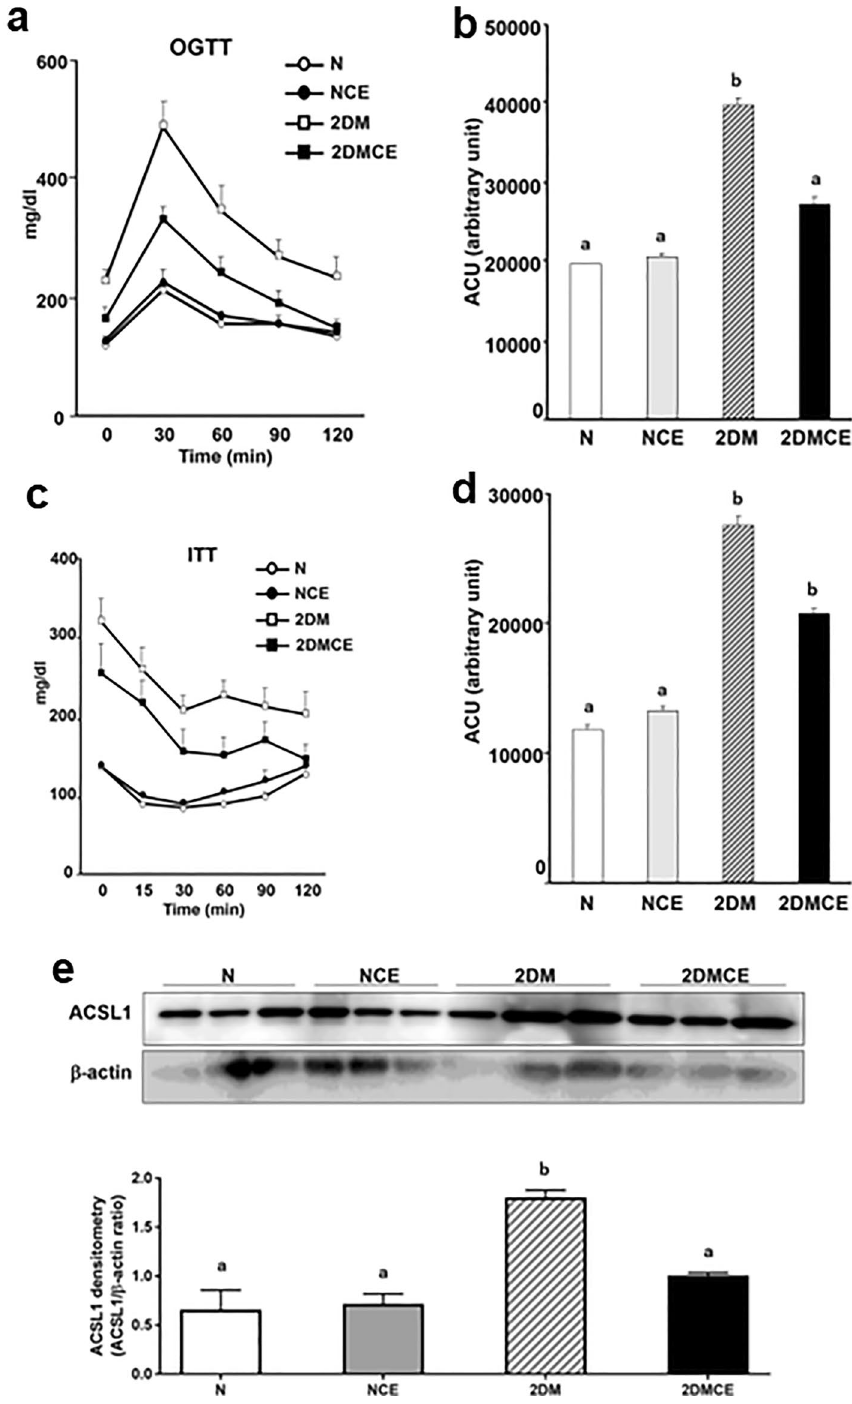
Figure 5. Cinnamon extract (CE) improves glucose intolerance and ACSL1 protein expression in type 2 diabetic mice. N: nondiabetic normal control group. Mice were orally administered 1-mL pure water for 8 weeks. NCE: CE-treated nondiabetic normal control group. CE (100 mg/kg bw/day) was orally administered for 8 weeks. 2DM: type 2 diabetes model mice group. Mice were orally administered 1-mL pure water for 8 weeks. 2DMCE: CE-treated type 2 diabetes model mice group. CE (100 mg/kg bw/day) was orally administered for 8 weeks. ( a ) For the oral glucose tolerance test, the mice fasted for 6 h prior to the test. Glucose (1.5 g/kg bw) was orally administered, and the blood glucose concentration was measured using the blood obtained via the tail vein at the indicated time points after the oral glucose loading. ( b ) The area under the curve (AUC) of the oral glucose tolerance test for panel ( a ). ( c ) For the insulin tolerance test, the rats fasted for 2 h. Then, insulin (0.75 U/kg bw) was intraperitoneally injected, and the blood glucose concentration was measured as previously described. ( d ) The AUC of the insulin tolerance test for panel c. Each value represents the mean ± SD of three different mice (n = 3/group). Alphabet letters indicate intergroup comparisons. Different alphabets indicate statistically significant differences among groups (P<0.01). ( e ) Western blot was employed to detect ACSL1 protein in the adipose tissue. The image is a cropped blot and the full-length images of the western blot are provided in Supplementary Fig. S5a and b. Each value represents the mean ± SD of three different mice (n = 3/group). Alphabet letters indicate intergroup comparisons. Different alphabets indicate statistically significant differences among groups